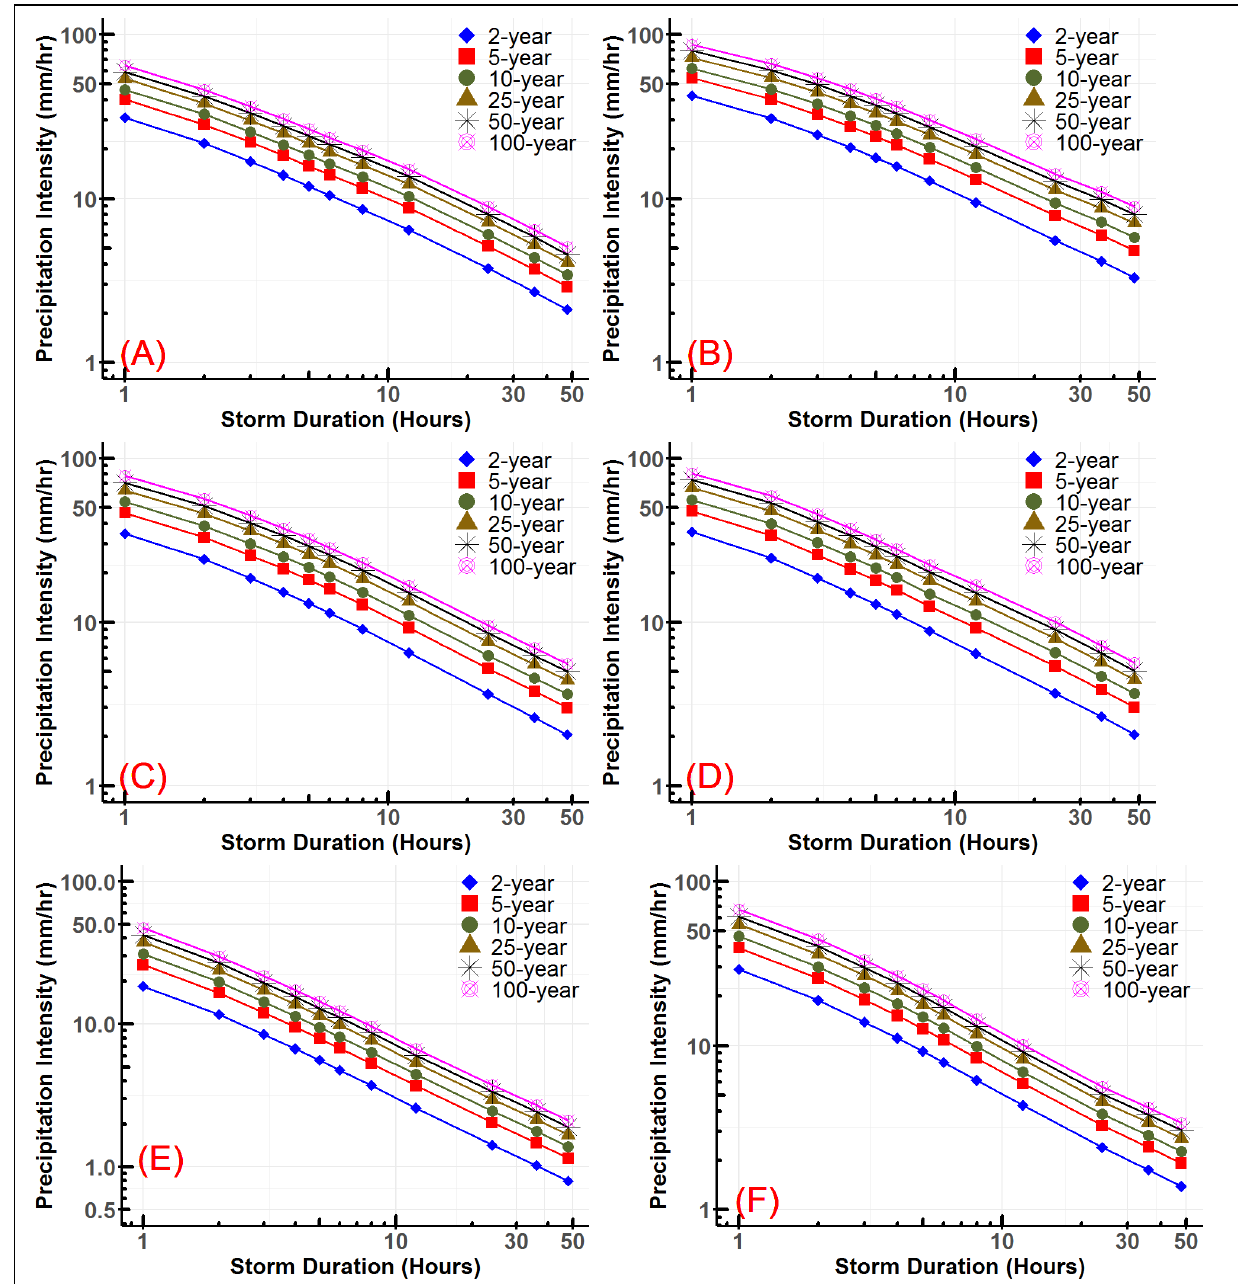
Figure 8. IDF curves for ( A ) Dallas-Fortworth, ( B ) Houston, ( C ) San Antonio, ( D )McAllen, ( E ) El Paso, and ( F ) Amarillo (both x -axis and y -axis are in logarithmic scale for legibility of the curves).